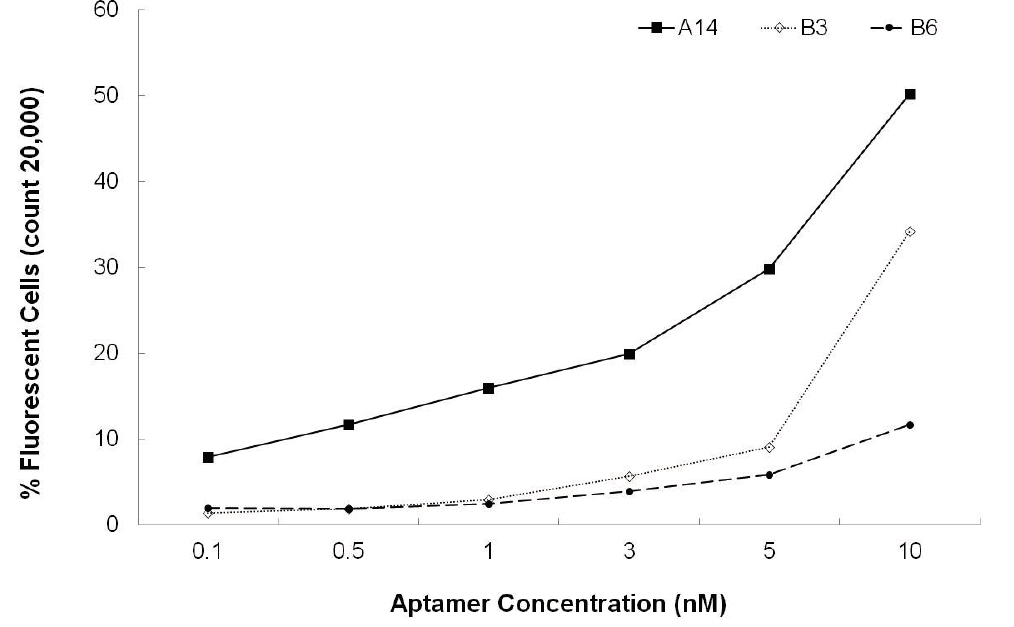
Figure 3. Characterization of aptamers A14, B3, and B6